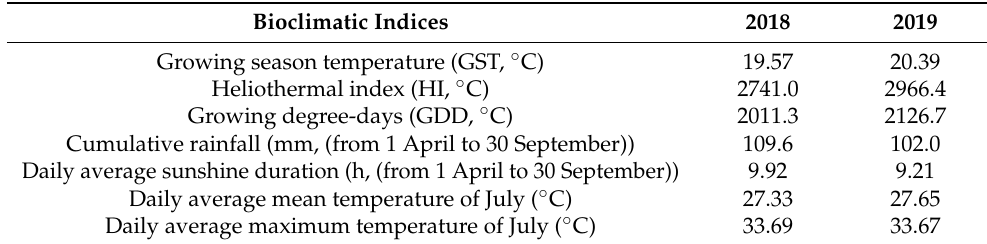
Table 1. Meteorological data from the vintages of 2018 and